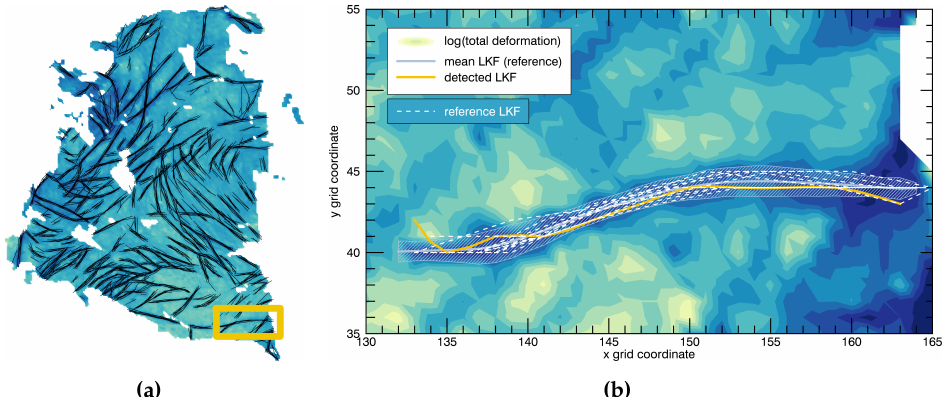
Figure 7. Intrinsic accuracy of the validation data. ( a ) Reference features in R 0 . The yellow box marks the location of Figure 7b; ( b ) Reference line example. Hatched area: mean value ± standard deviation of the seven individually determined results from the R 0 data set (dashed white lines).